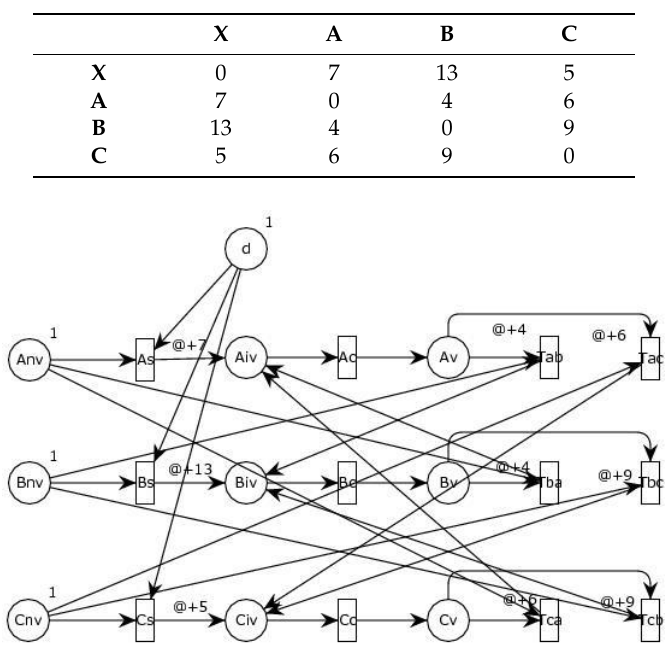
Table 6. Symmetric cost matrix for three cities. Table 4. Symmetric cost matrix for three cities.